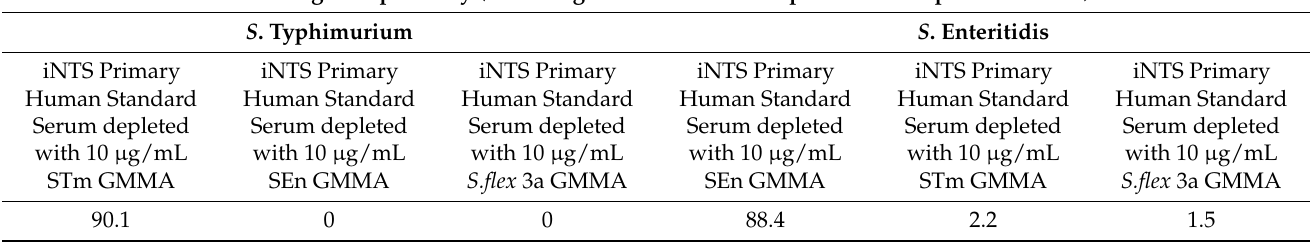
Table 3. Percentage of IC50 depletion compared to undepleted control in presence of homologous and heterologous competitors at concentration established in the previous set of